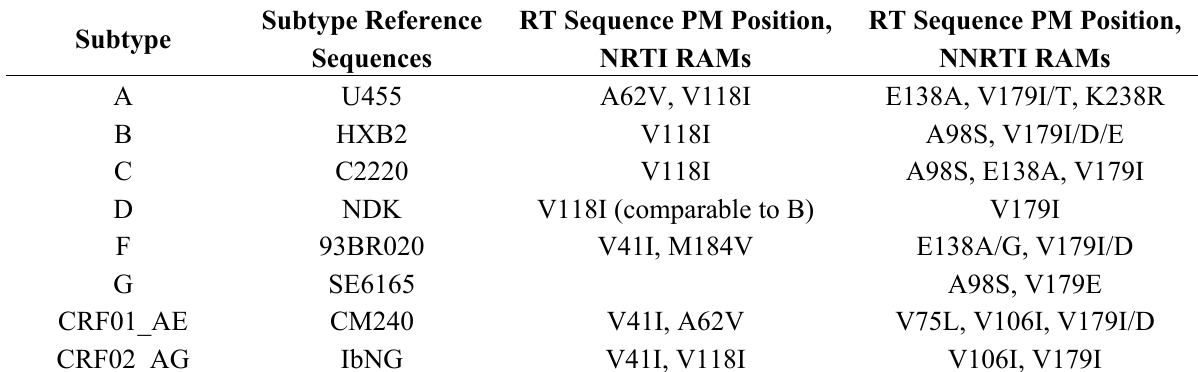
Table 2. Polymorphism at drug resistance positions in RT from untreated patients (modified from Kantor and Katzenstein,